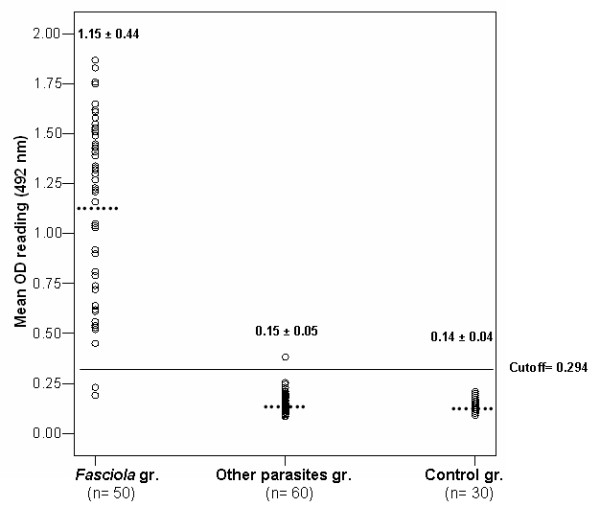
Level of Fasciola ES antigen detected in stool samples of different studied groups measured by sandwich ELISA (OD reading at 492 nm). The horizontal line represents the cut-off value of the assay (the lower detection limit). Dotted lines represent the mean OD value.